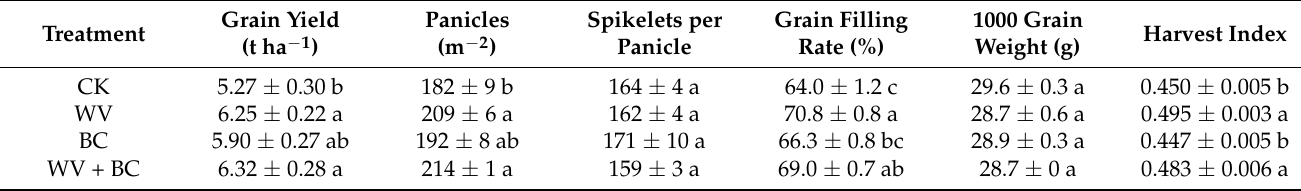
Table 7. Grain yield, yield components, and harvest index of different seed treatments of WDR under field